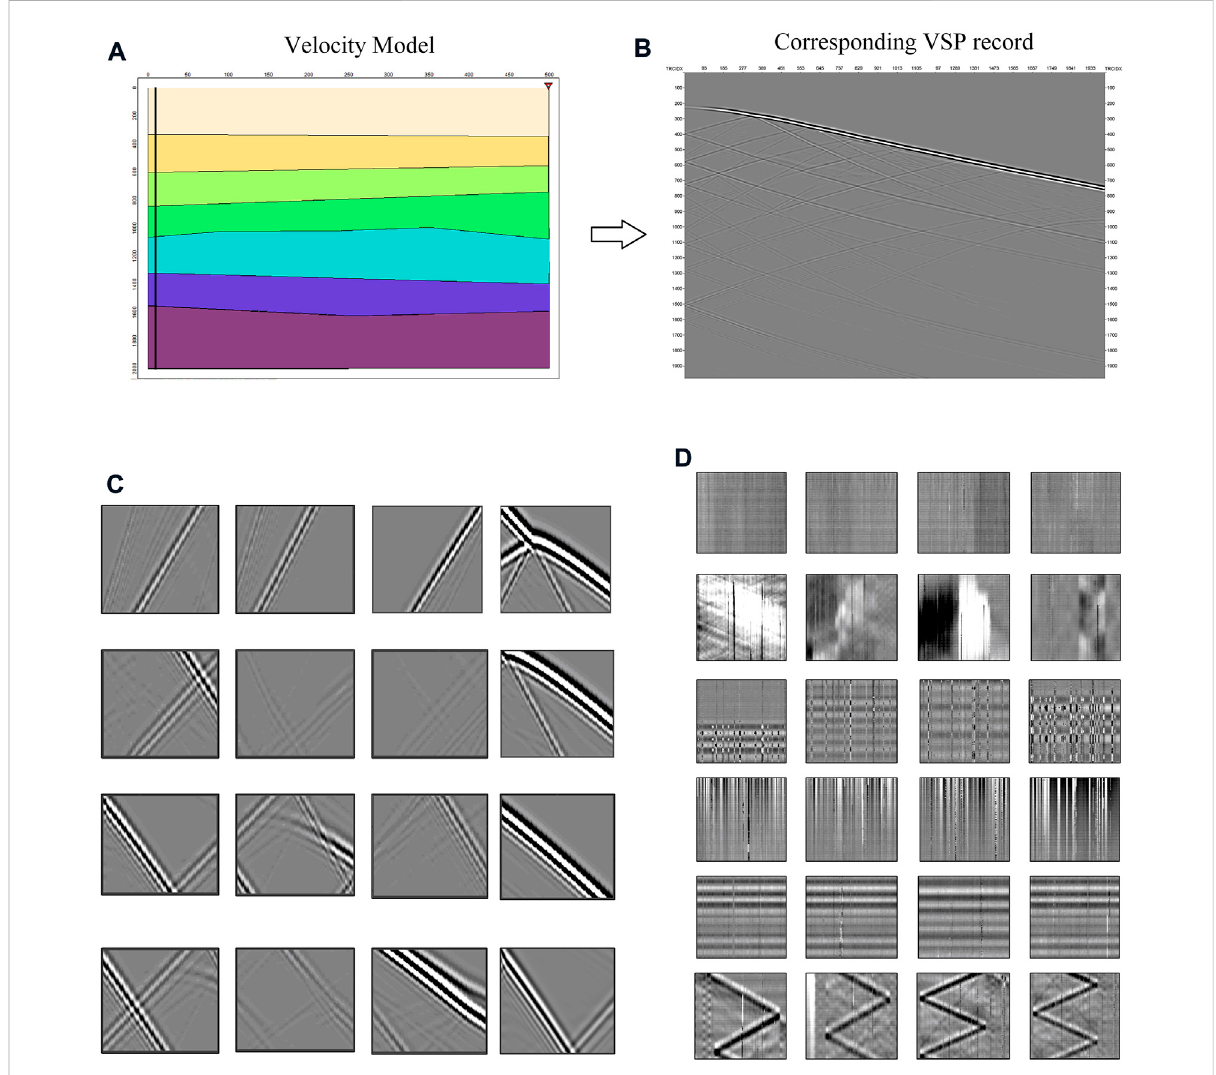
FIGURE 2 Construction of the dataset. (A) The velocity model. (B) The corresponding synthetic DAS-VSP record. (C) Samples of the signal dataset. (D) Samples of the noise dataset. These patches are the random noise, the abnormal interference, the checkerboard noise, the fading noise, the horizontal noise and the coupling noise from top to